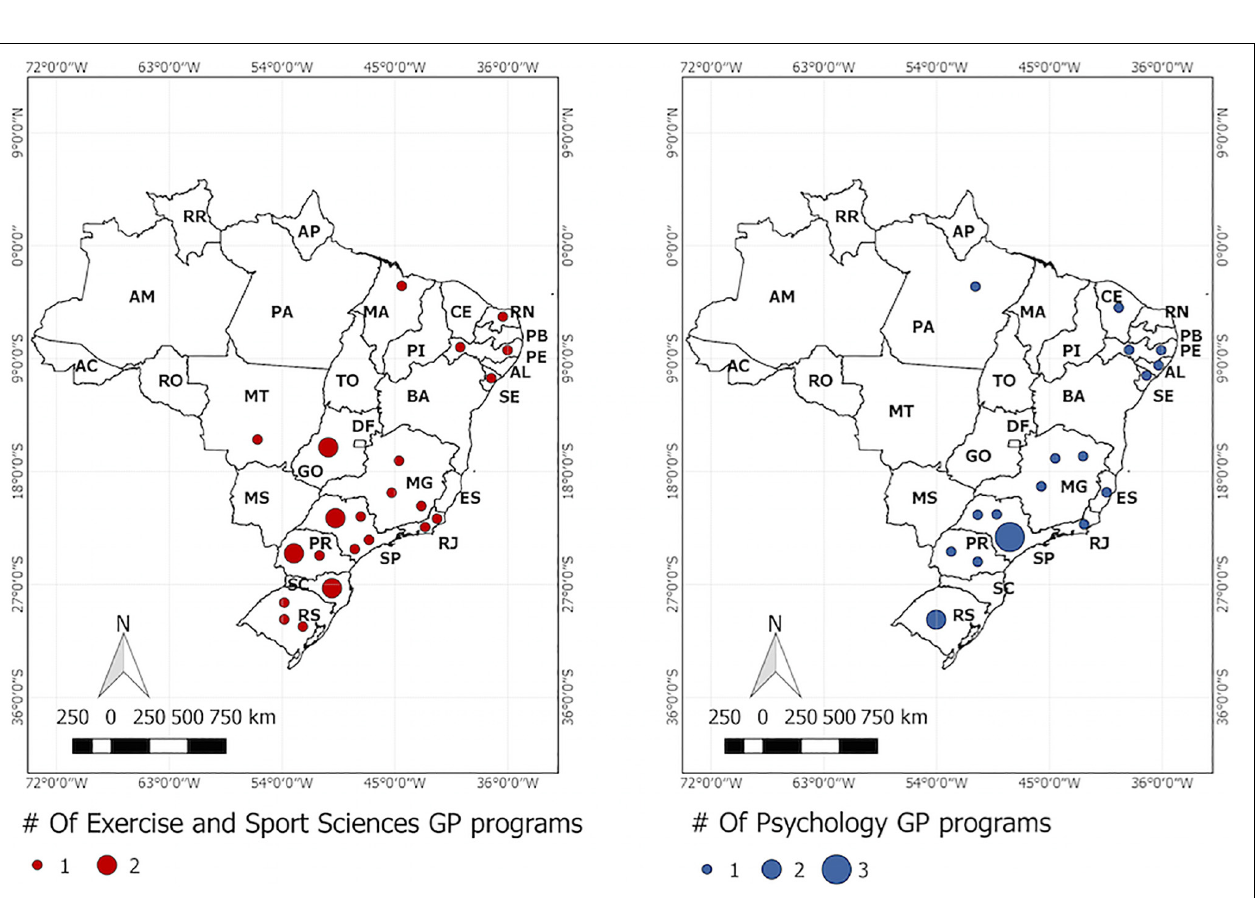
FIGURE 3 | Distribution of Exercise and Sport Science and Psychology GPs with Sport and Exercise Psychology researches in Brazilian cities.